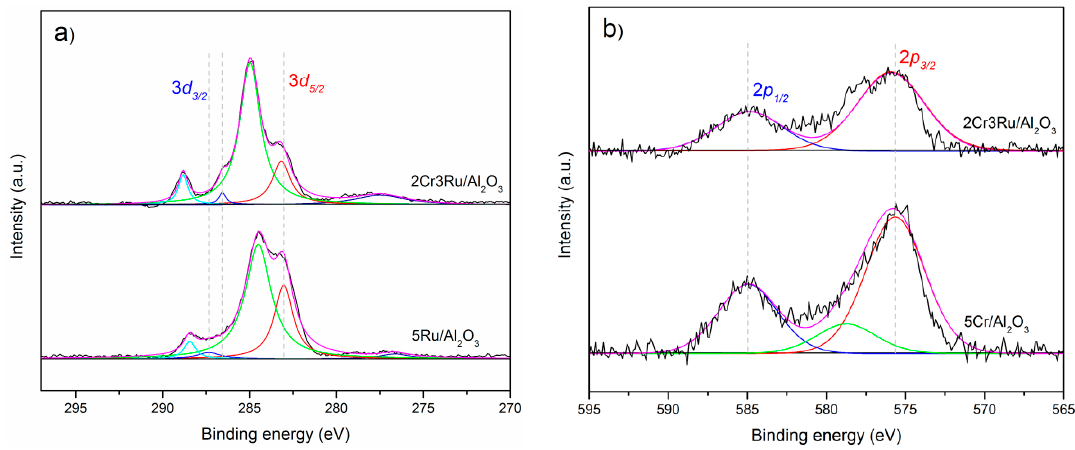
Figure 7. XPS spectra of ( a ) Ru 3d and ( b ) Cr 2p regions obtained from 5Ru / Al 2 O 3 , 5Cr / Al 2 O 3 , and 2Cr3Ru / Al 2 O 3 catalysts.